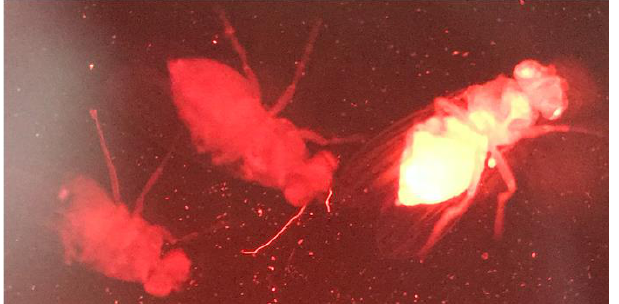
Figure 3. Example of DsRed-expressing (right) and -non-expressing (left) flies. The photograph was cropped to remove the microscope objective edges visible at the border of the image.